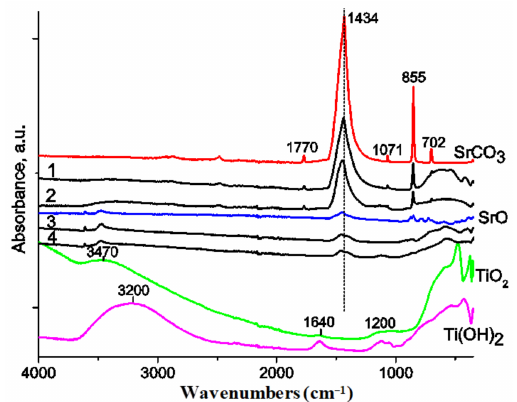
Figure 2. FT-IR spectra of the initial compounds and MA products after mechanical activation for 10 min. 1—MA-1, 2—MA-2, 3—MA-3,